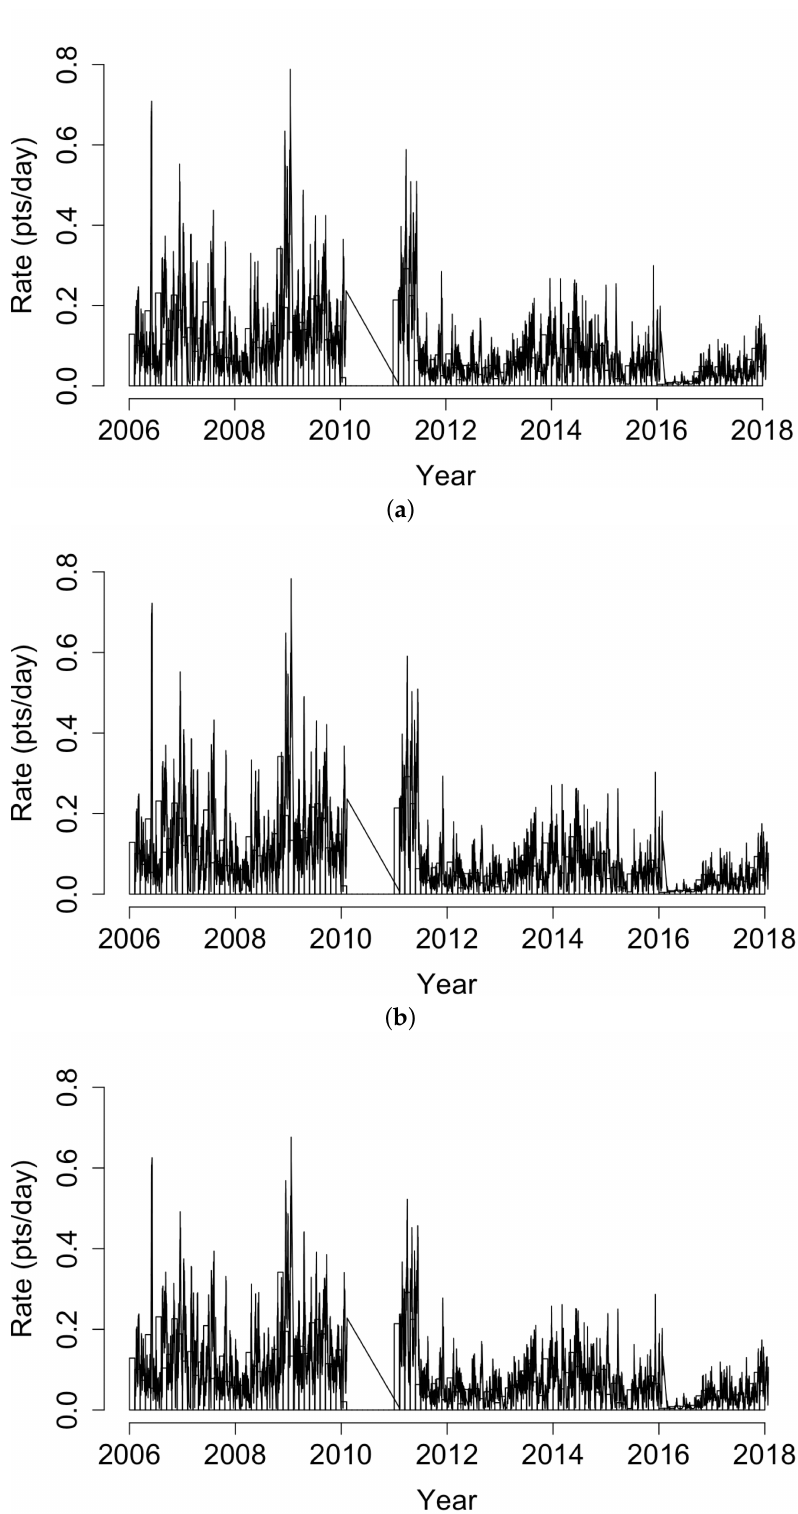
Figure 2. Histogram of coccidioidomycosis cases in California along with the estimated conditional intensity of the fitted Hawkes model with ( a ) power law triggering, ( b ) the Hawkes model with exponential triggering, and ( c ) the recursive